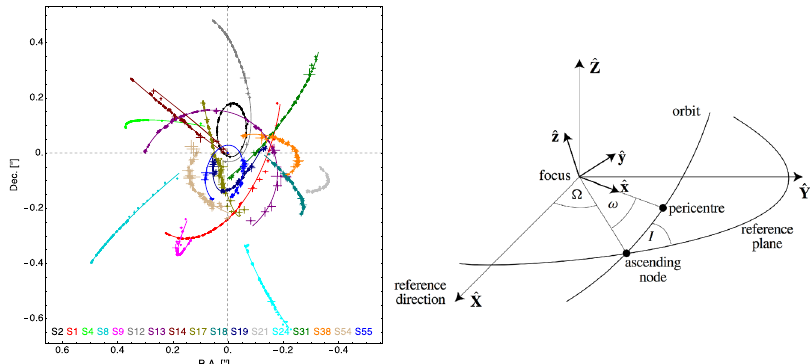
Fig. 31 Keplerian orbits around an MBH. Left: Detailed observations of the Keplerian dynamics of the S- stars in the vicinity of Sgr A* ( (cid:1) 10mpc) from Gillessen et al. (2017). At leading order, orbits take the form of closed ellipses, because the central MBH dominates the gravitational potential. Right: Illustration of the Keplerian orbital elements from Murray and Dermott